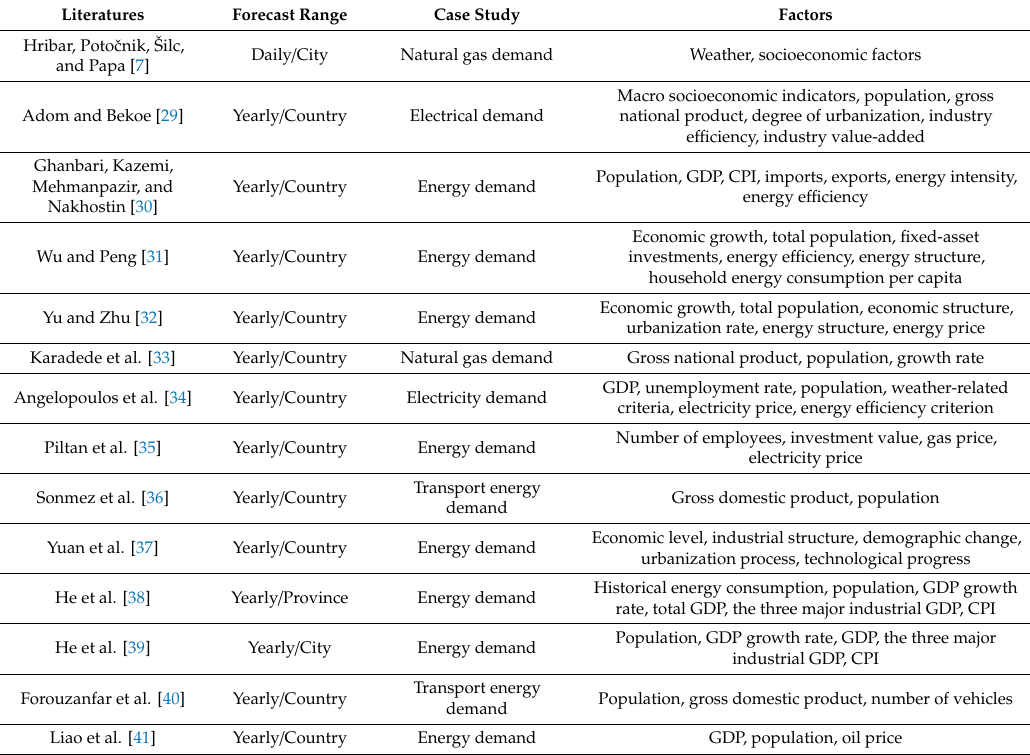
Table 1. Influencing factors of energy